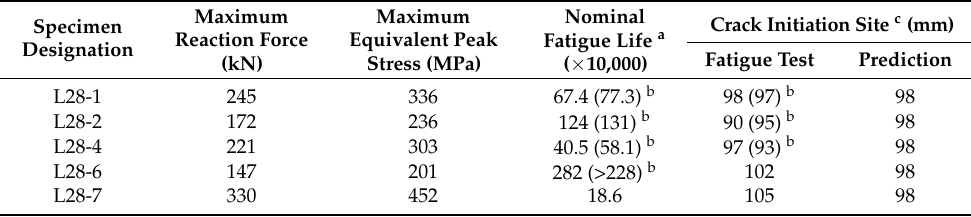
Table 2. Fatigue test results of the variable-section supports with R-plates.